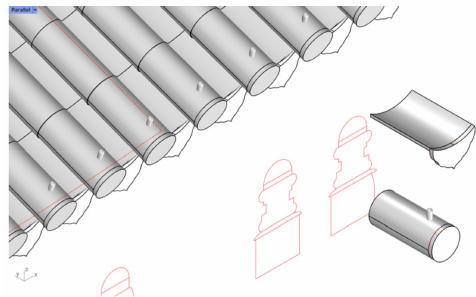
Figure 21. The prototypes of Block Definition.